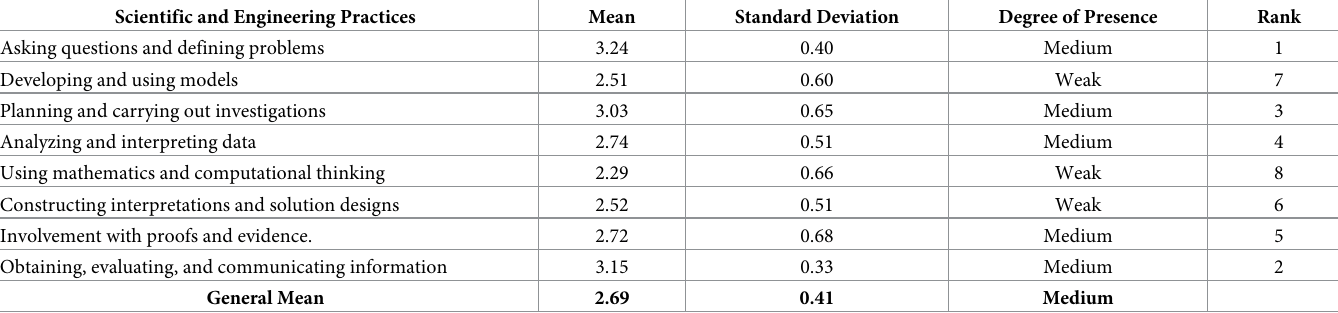
Table 1. The means and standard deviations for teachers’ responses to the scientific and engineering practices questionnaire. Scientific and Engineering